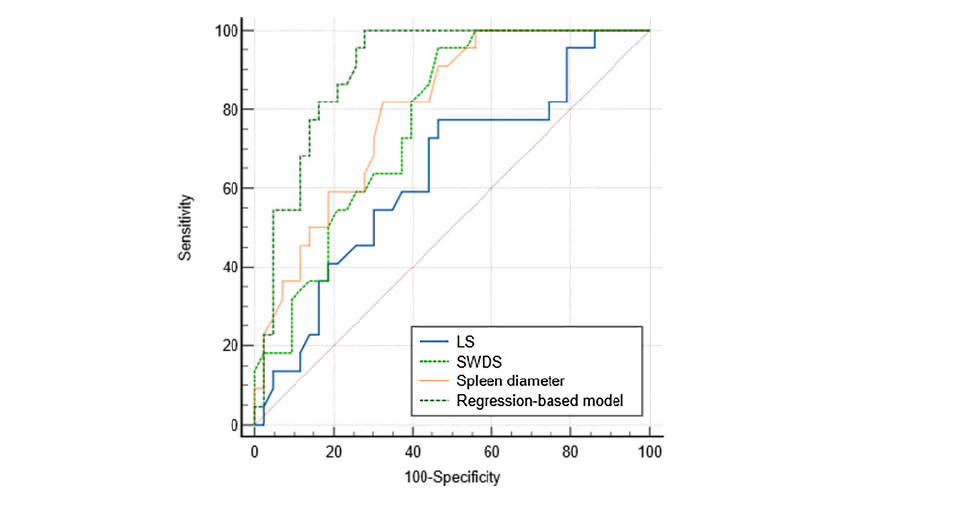
Figure 2. Comparison between AUCs of LS, SWDS, spleen diameter and the regression-based model. Table 2. Diagnostic performances of LS, SWDS, spleen diameter and the regression-based model for VH.